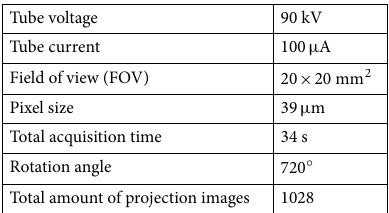
Table 1. MicroCT acquisition parameters.